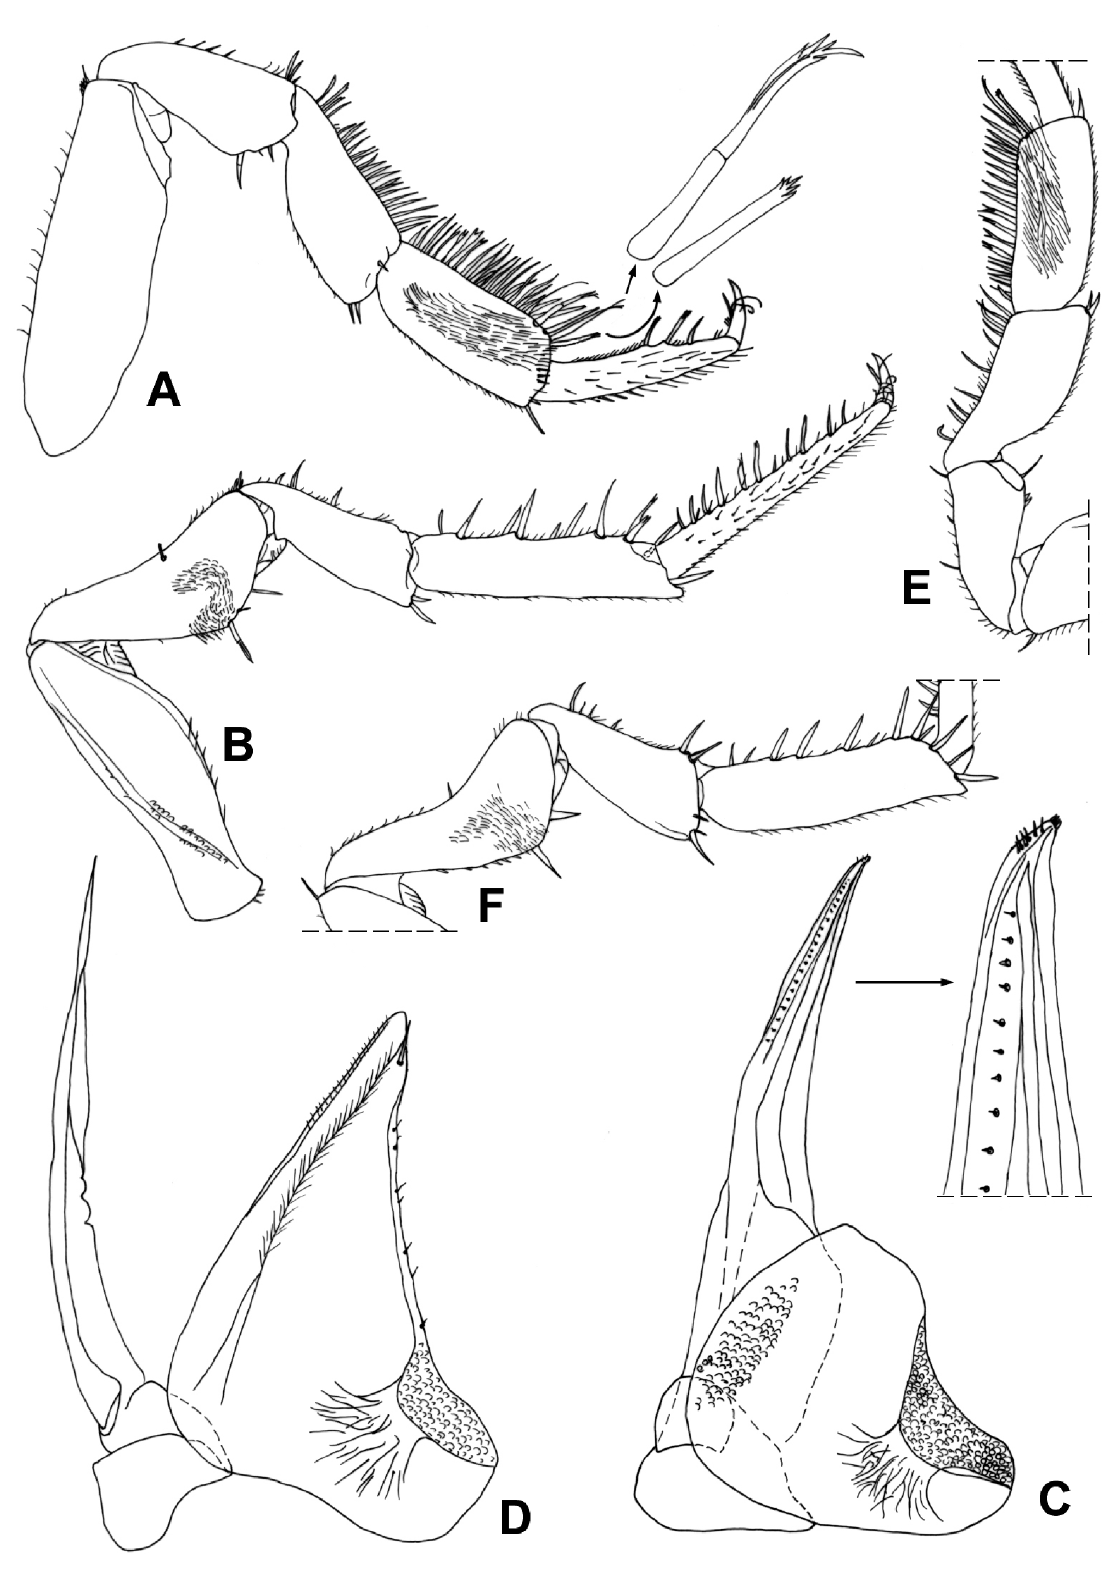
Fig. 29. Porcellio cavernicolus Vandel, 1946. — ♂ from Gruta da Cerâmica, Sicó. A . Pereopod 1. B . Pereopod 7. C . Pleopod 1. D . Pleopod 2. — ♂ from Gruta d’el Rey, Cantanhede-Outil Massif. E . Pereopod 1. F . Pereopod